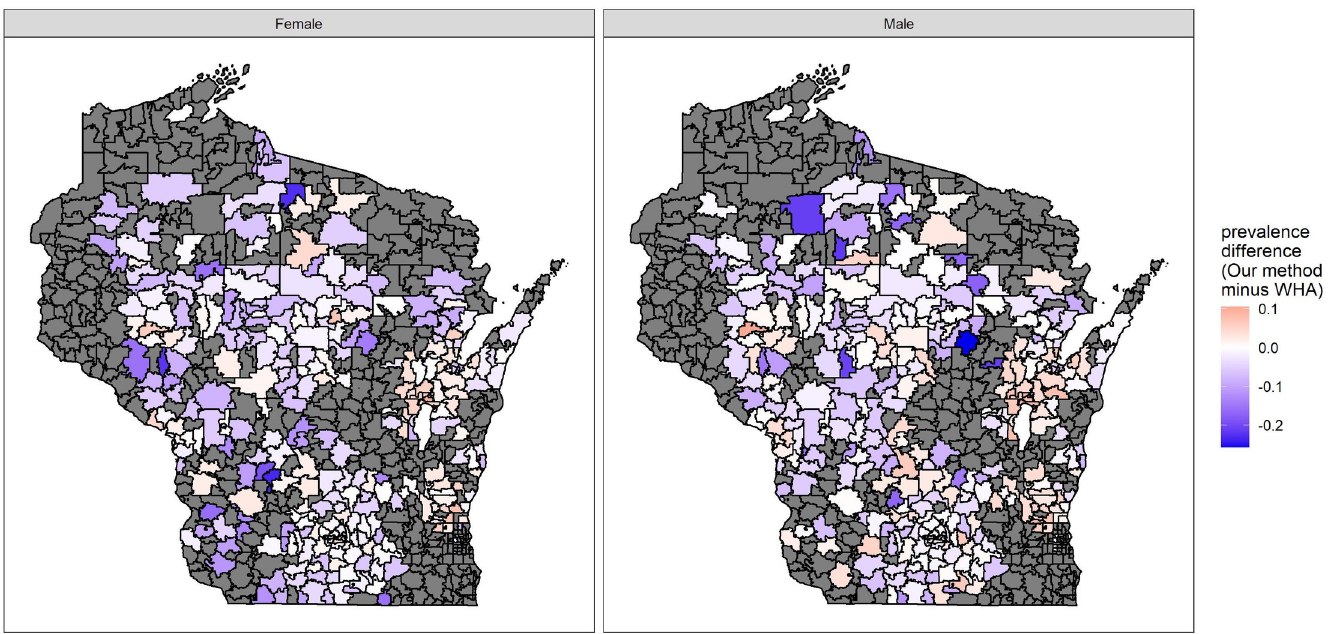
Fig 3. Differences in prevalence estimates across the State of Wisconsin from PHINEX and WHA (left panel: Male, right panel: Female).